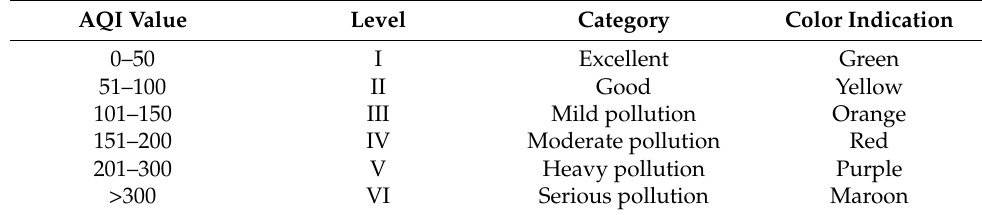
Table 2. AQI scope and air quality category.